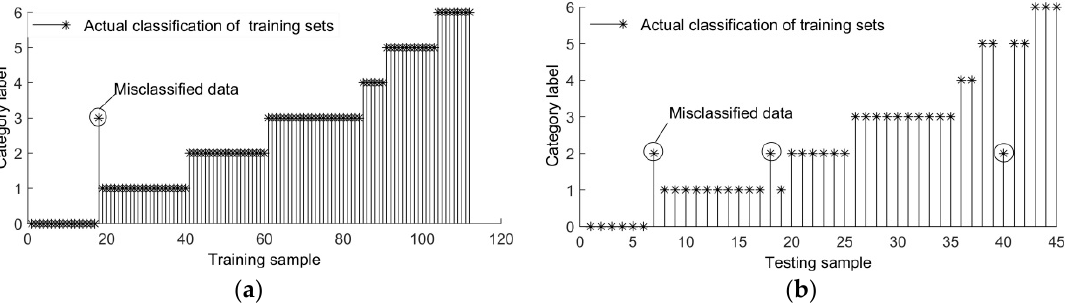
Figure 2. Results of the transformer-failure diagnosis: ( a ) training sets; ( b ) testing sets.